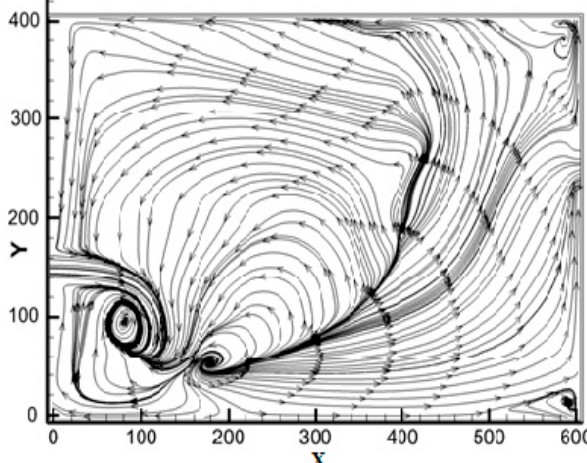
Figure 6. Stream Lines 15.5 cm from the bed, G374 reservoir.